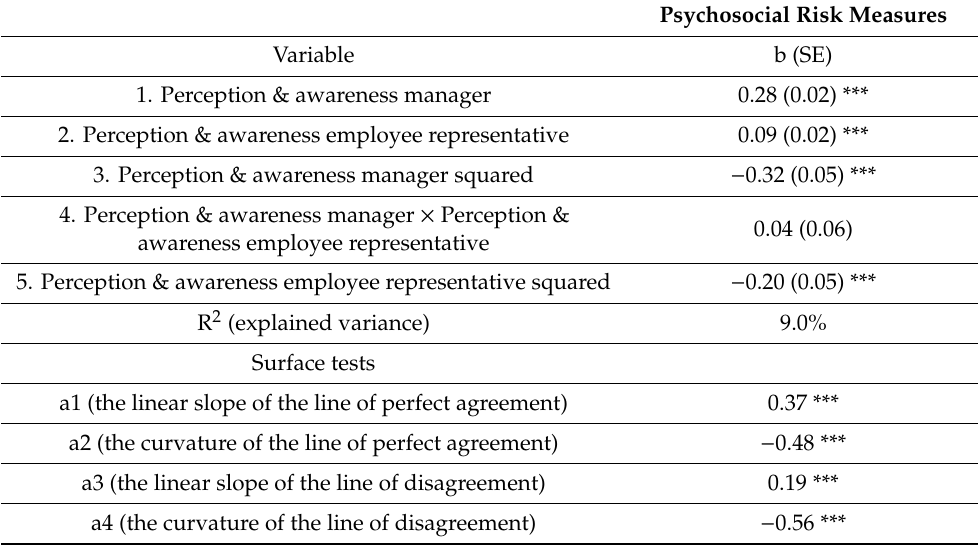
Table 4. Response surface tests for psychosocial risk perception and awareness of the manager and the employee